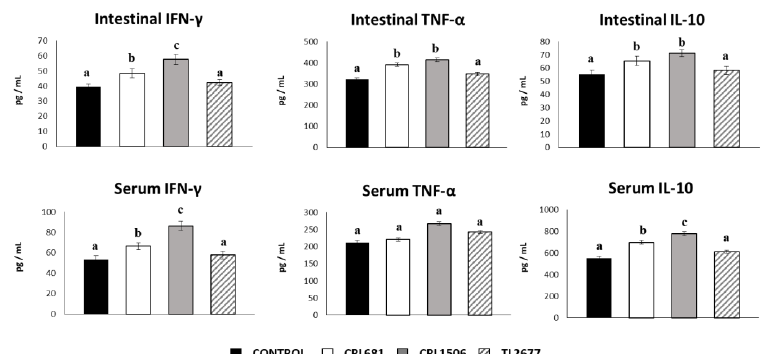
Figure 6. Effect of Lactiplantibacillus plantarum CRL681, CRL1506 or TL2677 on intestinal and serum cytokines of adult immunocompetent mice after enterotoxigenic Escherichia coli (ETEC) challenge. Mice were orally treated with L. plantarum CRL681, CRL1506 or TL2677 (10 8 cells/mouse per day for 5 consecutive days) and then challenged orally with ETEC F4 strain (10 9 cells). Mice with no lactobacilli treatment and challenged with ETEC were used as controls. Two days after the challenge, the concentrations of tumor necrosis factor (TNF)- α, interferon (IFN) - γ, and interleukin (IL) -10 in intestinal fluid and serum were determined by ELISA. The results represent three independent experiments. Results are expressed as mean ± SD. Bold letters indicate significant differences when compared to the control group ( p < 0.05).